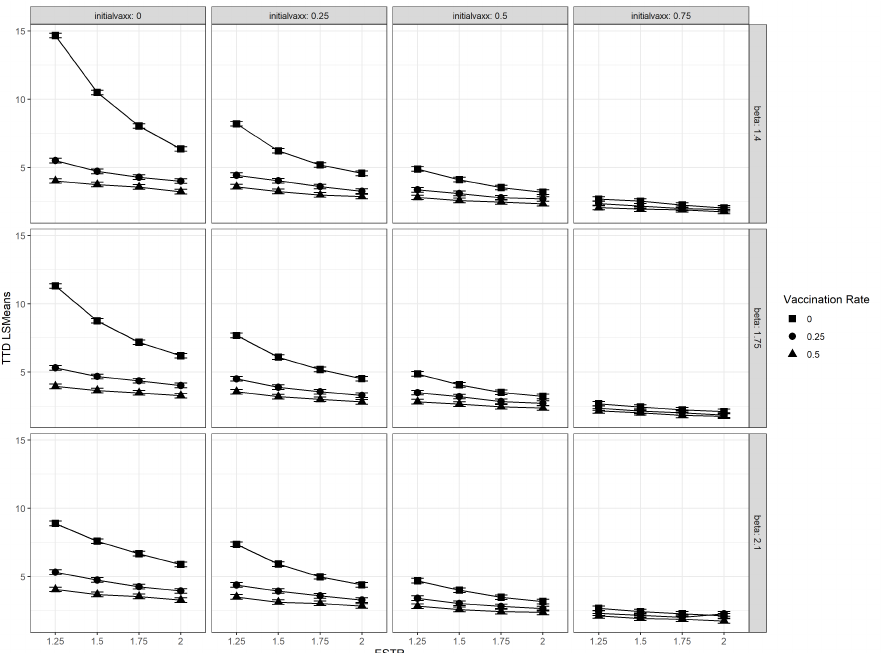
Figure 5. The interaction plots of the vaccination rate and emergent strain transmission ratio (ESTR) for different combinations of the initial vaccination coverage (initialvaxx), and transmission coefficient of the existing strain